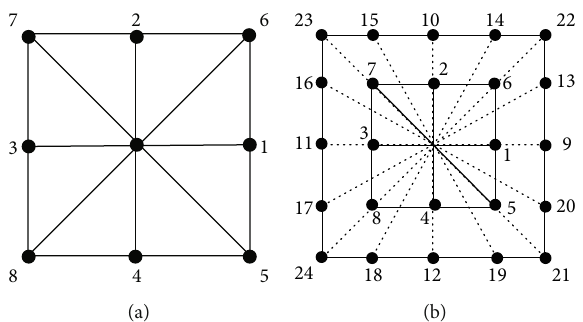
Figure 1: Node distributions for calculating the fl uid- fl uid cohesion force in (a) one-layer and (b) two-layer models [38].